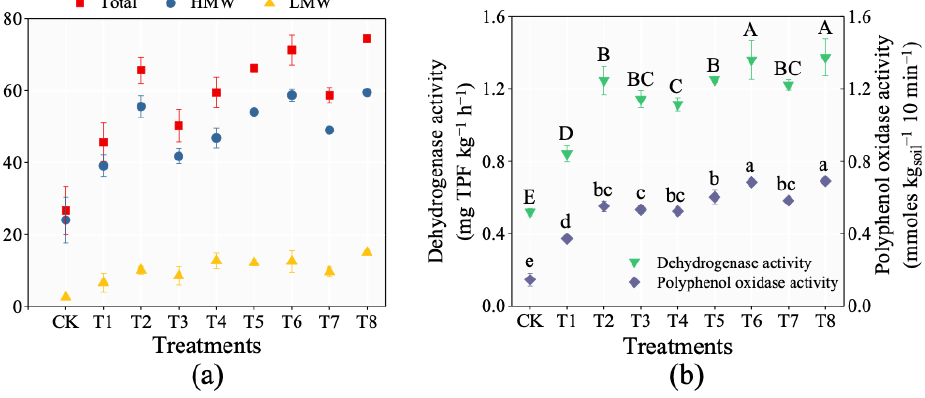
Figure 5. ( a ) Degradation rates of total, HMW, and LMW PAHs. ( b ) Soil polyphenol oxidase and dehydrogenase activities after incubation for 24 days. Different letters (A–E and a–d) indicate significant differences in the concentrations of PAHs among different treatments according to the one-way analysis of variance (ANOVA) test followed by Tukey’s post hoc tests.